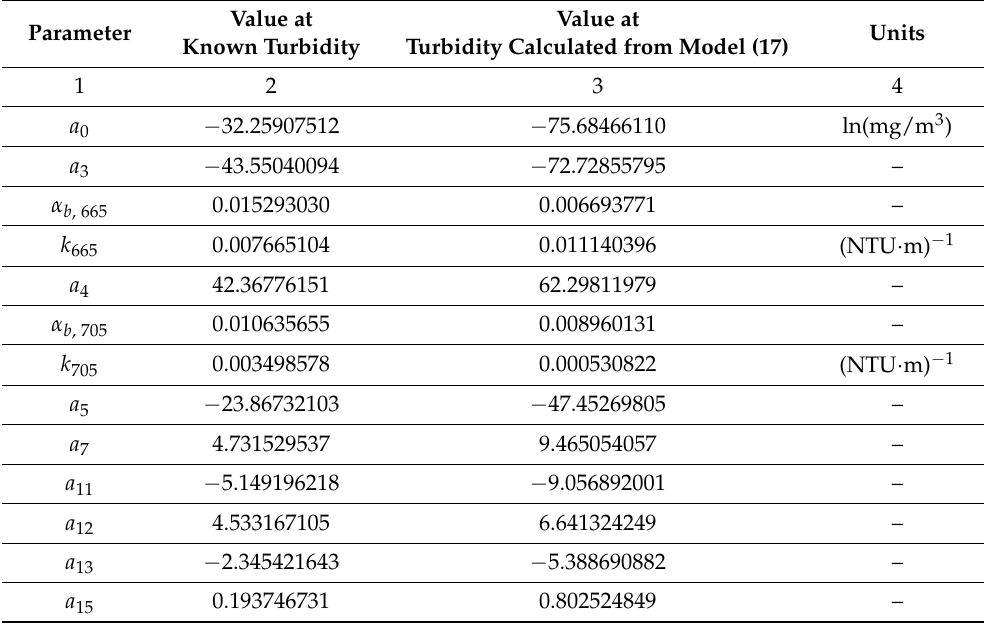
Table 2. Model parameters